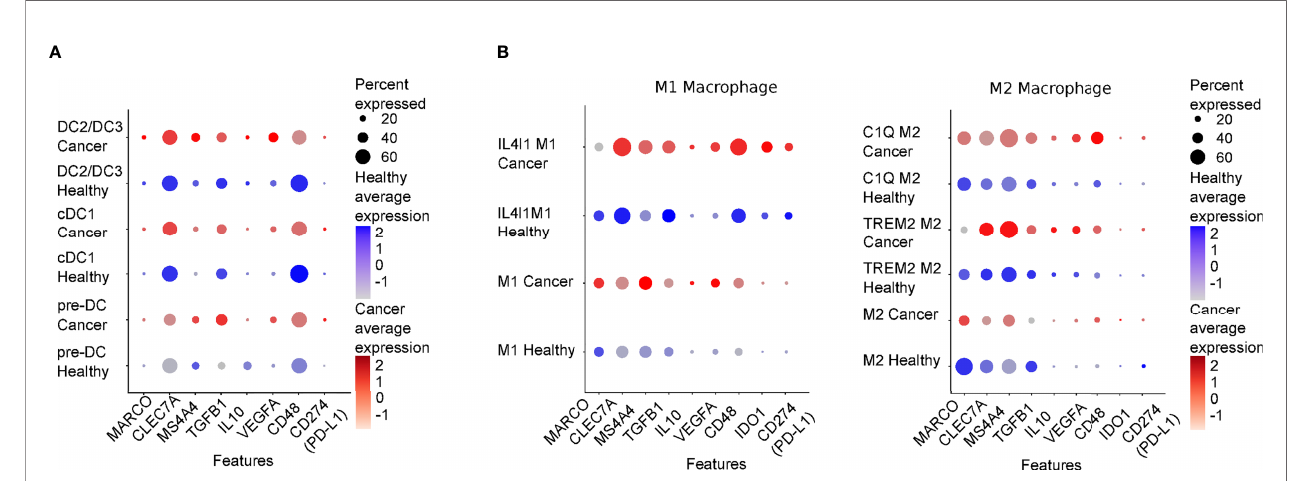
FIGURE 2 | Expression levels of genes regulating DC/NK macrophage/NK interplay in healthy tissues and cancer lesions. DotPlot showing relative expression levels of genes presented in this review in Dendritic (A) and Macrophages (B) populations comparing a merge of scRNAseq of different healthy tissues (Healthy) or of several cancer types (Cancer: lung, colon, liver, breast, stomach and pancreas). The scRNA datasets presented in this review were derived from (38), and were downloaded from “ https://gustaveroussy.github.io/FG-Lab/ ” . In detail, for the DC populations, classi fi ed in the MNP-VERSE dataset as pre-DC (progenitor DC), cDC1 and DC2/DC3 (that include cDC2 and DC3), while for the Macrophages populations (the function of which is described in the text), we relied on the “ MoMac- VERSE ” dataset. The indicated cell types were explored using Seurat (v4.04, https://satijalab.org/seurat/) within R version 4.0.5 (Shake and Throw). In blue and in red are shown the expression levels of healthy cancerous tissues, respectively. Color intensity is proportional to expression levels. MARCO, Macrophage receptor with collagenous structure; CLEC7A, C-type lectin domain family 7 member A or Dectin-1; IDO1, Indoleamine